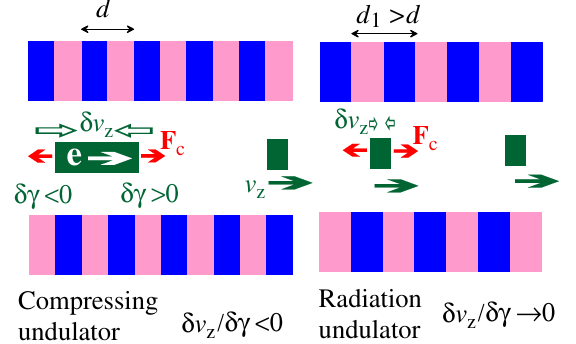
FIG. 1. Schematic of a rf source based on spontaneous coherent emission from short electron bunches, which includes compres- sion and radiation sections.